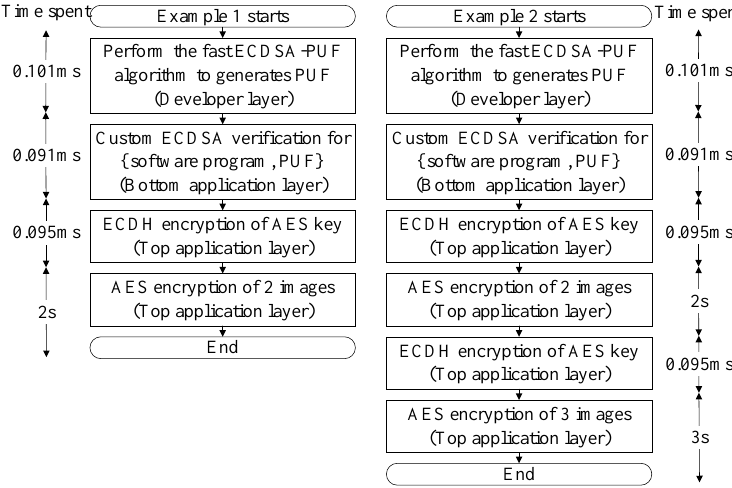
Figure 26. Triple-hybrid encryption system actual workflow in the